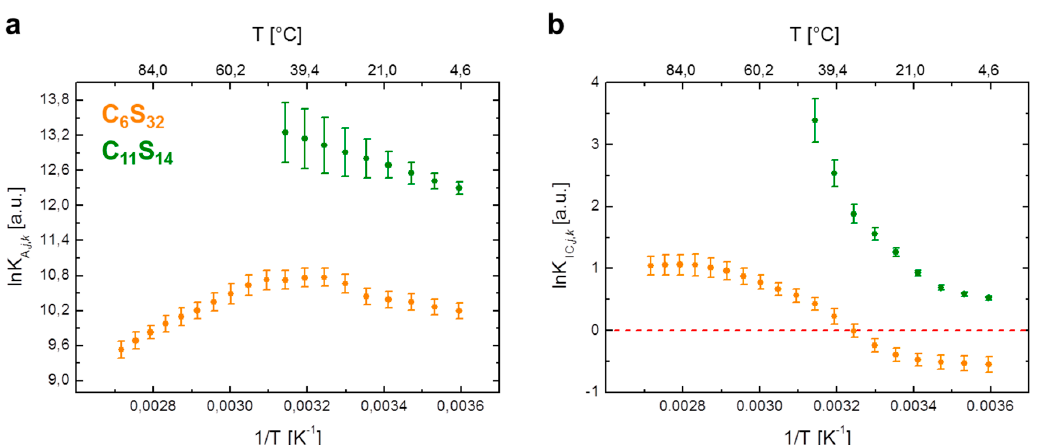
Figure 3. Van’t Hoff plots of 16-DSA in polymers C 6 S 32 and C 11 S 14 from EPR spectroscopy. Individual data points are calculated from EPR spectral deconvolution in Ref. [23] for ( a ) the ligand association constant (ln K A, j , k ) and ( b ) the interconversion process between Brownian and free diffusion (ln K IC, j , k ). The C 6 S 32 polymer curves are represented in orange and C 11 S 14 polymer curves in green throughout the whole manuscript. For raw data see Supplementary Tables S2 and S4.